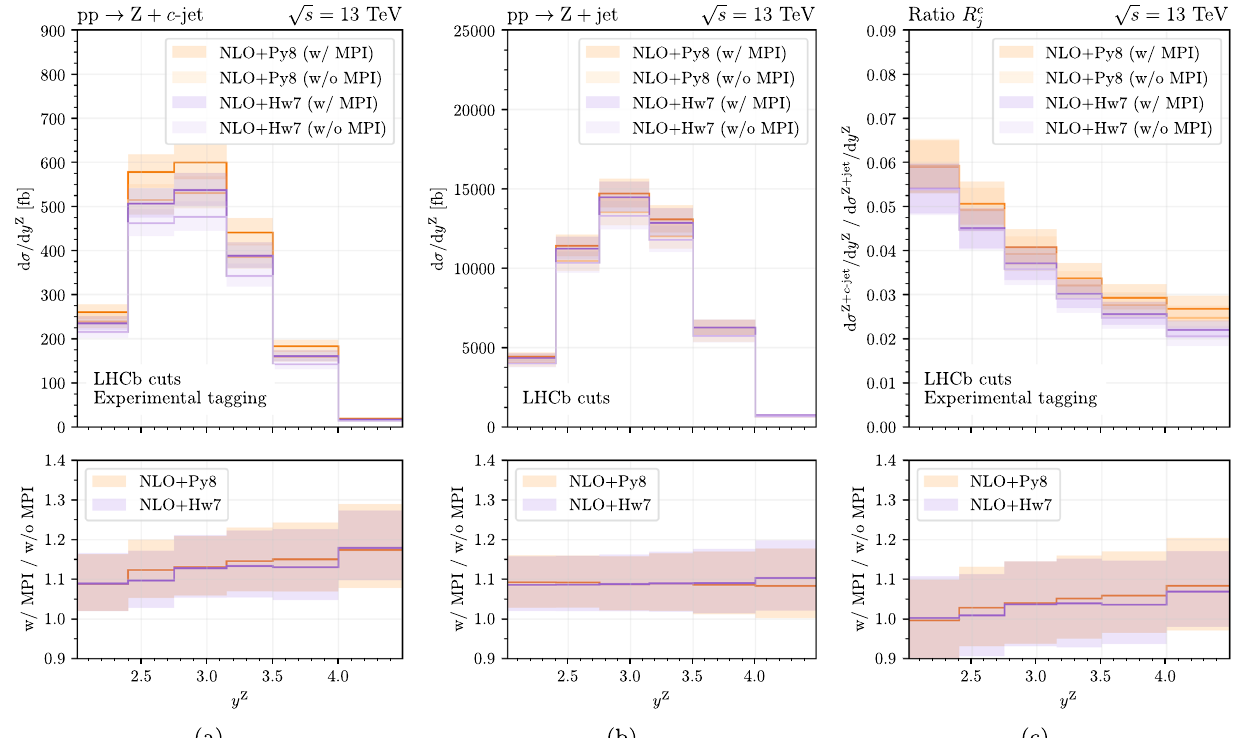
Fig. 7 Effect of MPI contributions on the Z rapidity distribution y Z in the Z + c -jet process ( a ), in the Z + jet process ( b ) and in the ratio of the two ( c ). NLO+PS predictions are obtained with Pythia8 (orange) or Herwig7 (purple) as parton showers. In the upper panels predictions